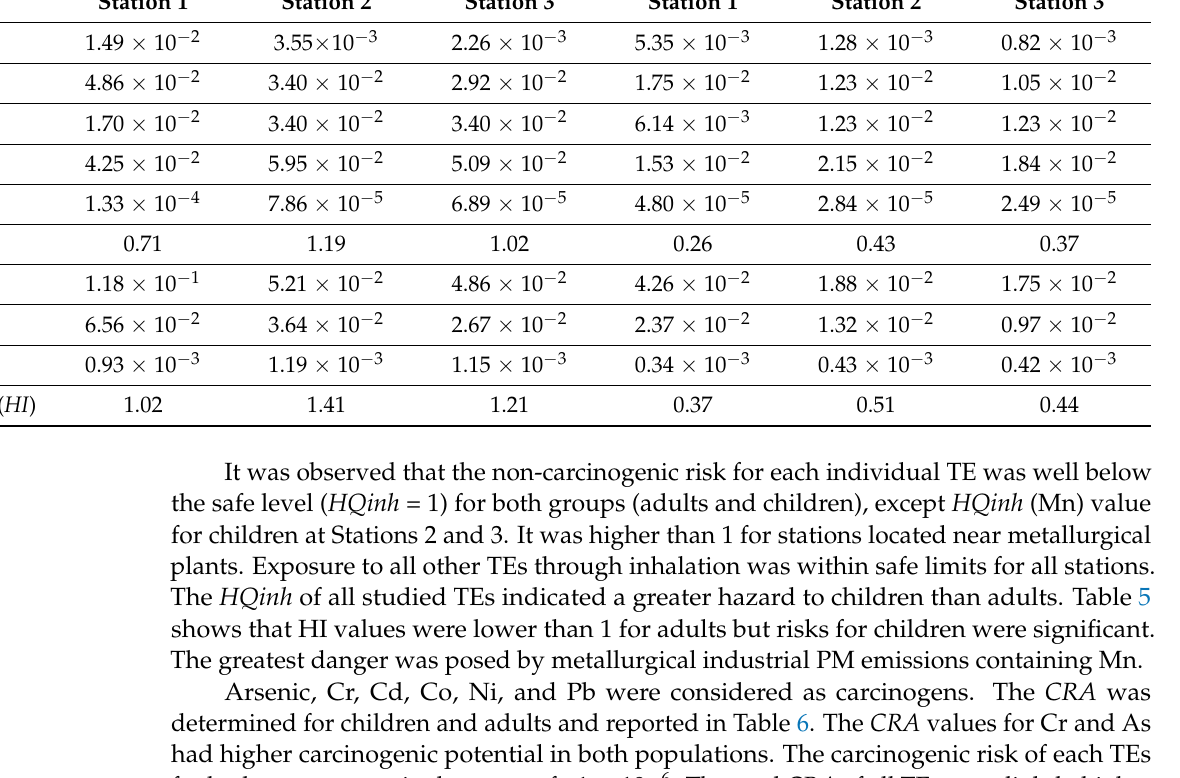
Table 5. The values of hazard quotient ( HQinh ) for children and adults in various stations. TE